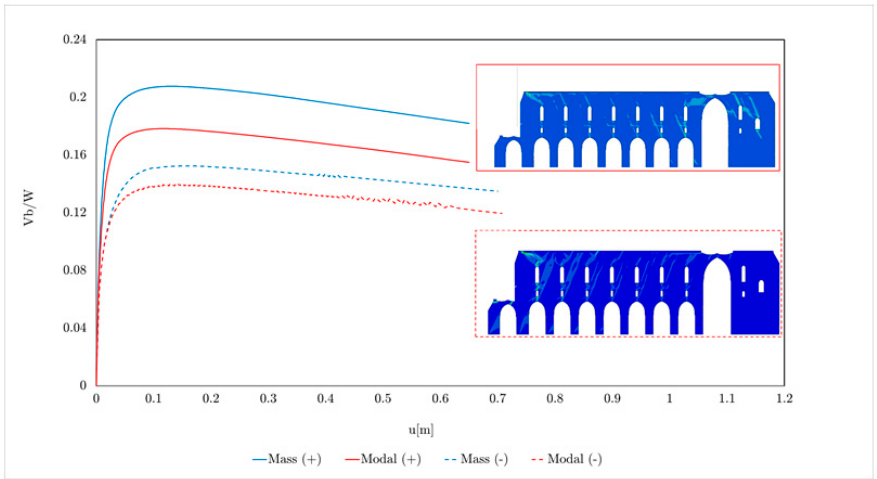
Figure 15. L macro-element: capacity